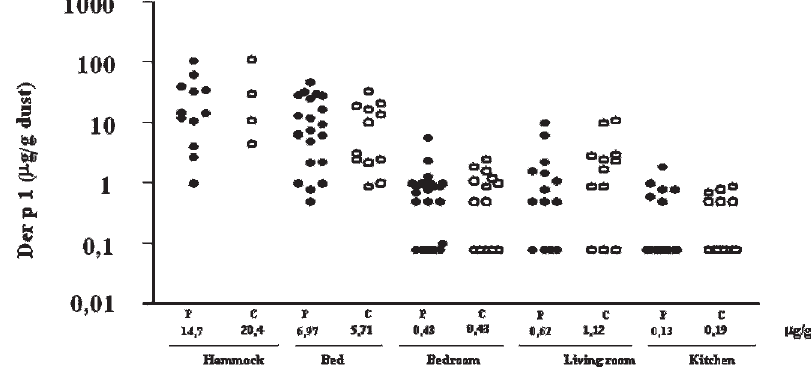
Figure 1 - The levels of Der p 1 in the dust samples collected from the homes of the asthma patients (dark circles) and the control subjects